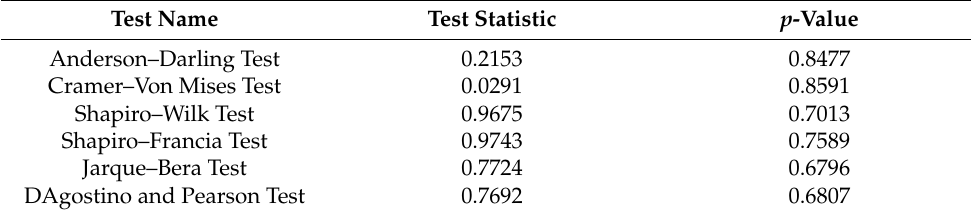
Table 2. Normality tests for maximum power growth.